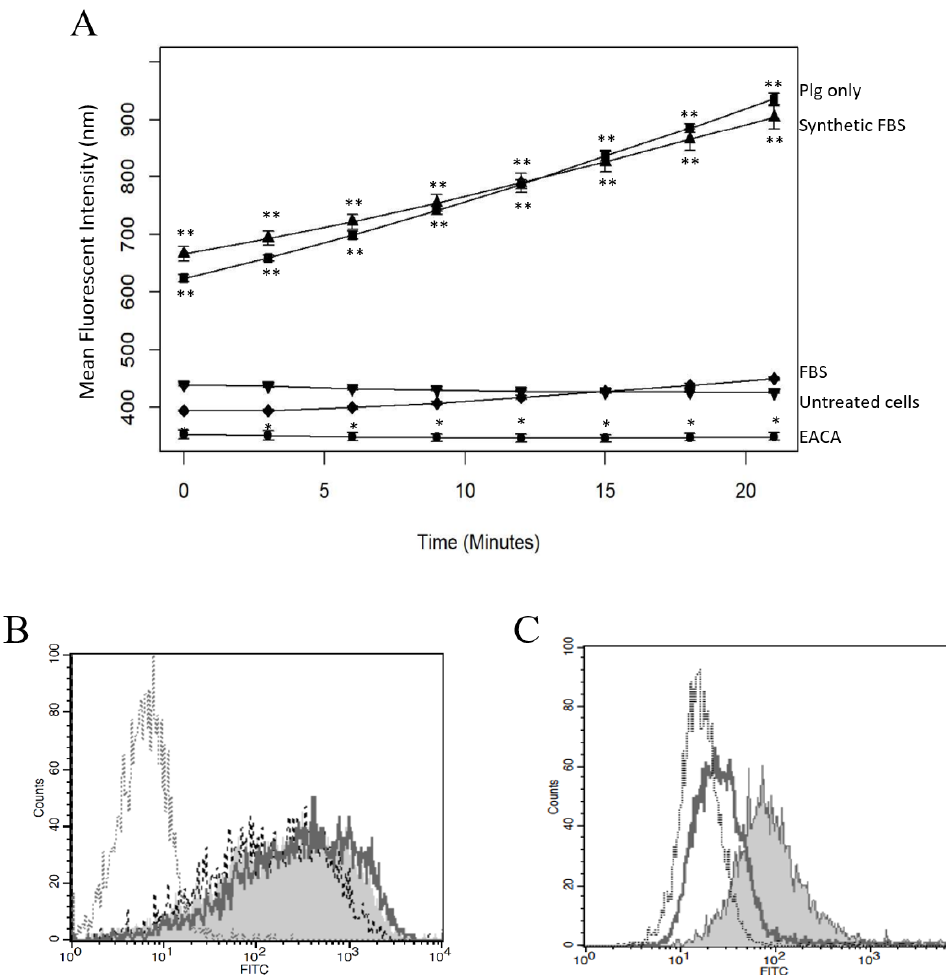
Figure 3. EACA and FBS Inhibit Lys-Plg Binding and Activation on MeT5A Cells. ( A ) Pla activity was significantly decreased when Plg was incubated with 1.6 mM M EACA (circle) compared to Plg only (square) and was similar for the control untreated cells (inverted triangle). Addition of animal-derived FBS (diamond) also significantly lowered Pla activity to negative control levels while addition of synthetic FBS (triangle) had no effect on Pla activity compared to Plg only. Plots are representative of at least three independent trials, n = 3 each, with error bars representing SD. Significance is * p ≤ 0.01, ** p ≤ 0.001, as compared to control. ( B ) Plg binding was not decreased upon addition of animal-derived FBS (- - -) or synthetic FBS ( _____ ) compared to Plg without FBS (grey shaded histogram), though binding was always higher than isotype control (.....). ( C ) Plg binding was decreased upon addition of 1.6 mM M EACA ( _____ ) compared to untreated Plg (grey shaded histogram). Plg treatment with EACA reduced binding to levels comparable to the isotype control ( ..... ).